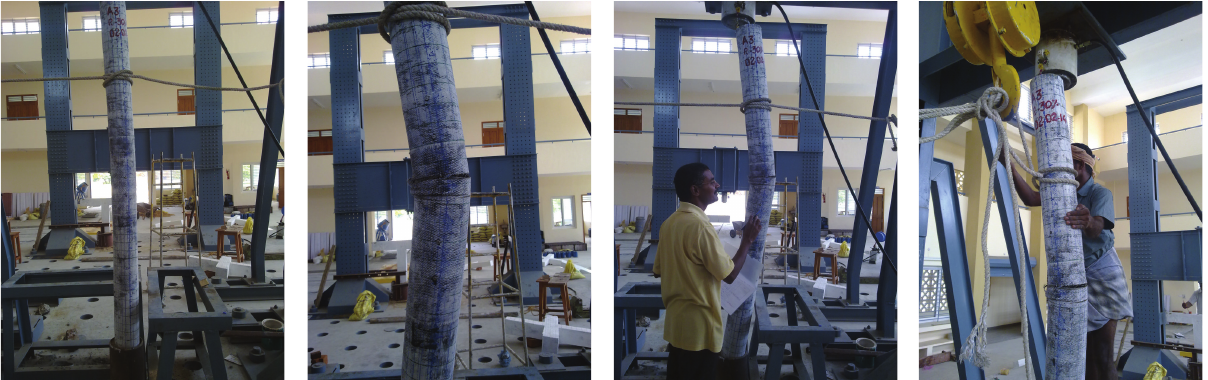
Figure 7: BFRP double wrapped elements testing.